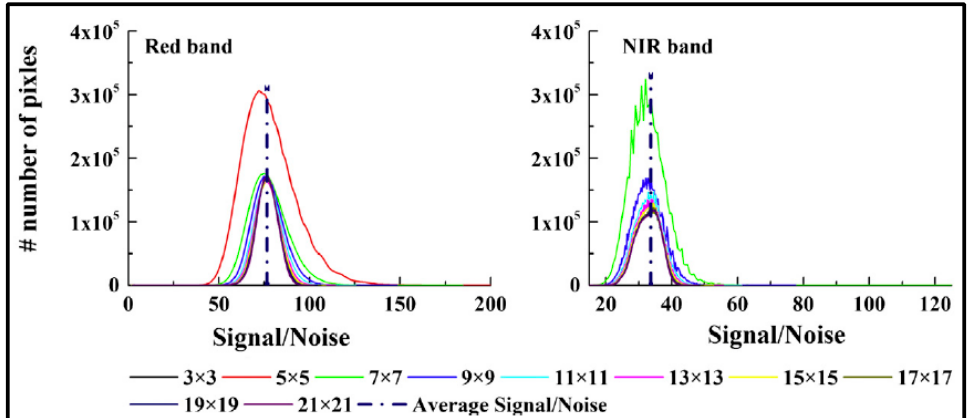
Figure 10: SNR as a function of wavelength[146] Figure 10. SNR as a function of wavelength